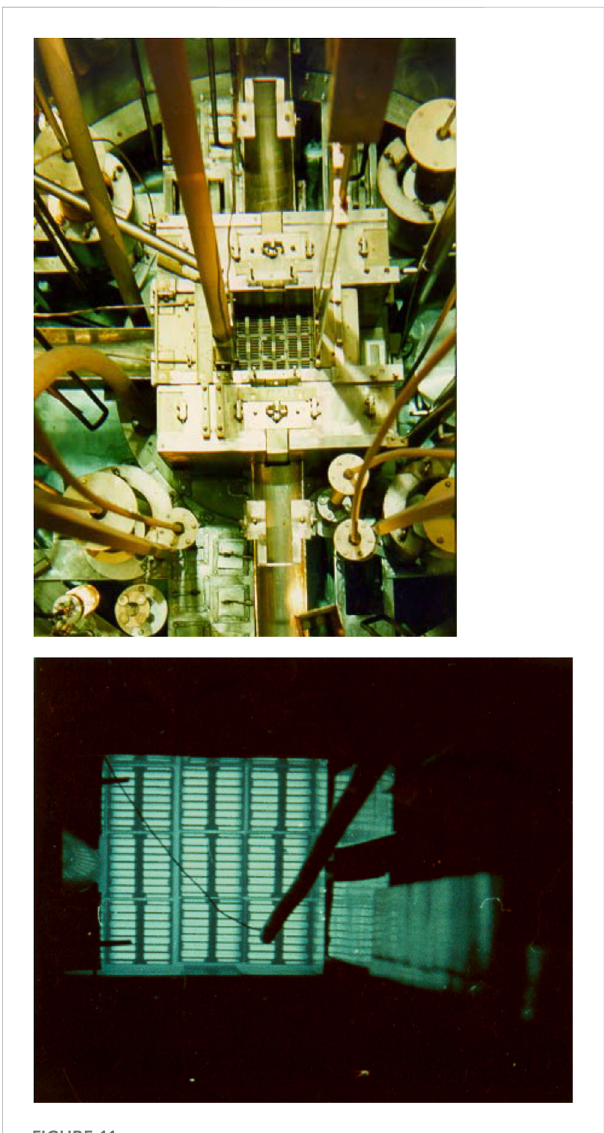
PhotoofKAMINIreactor(Top)andcherenkovradiation(Bottom).